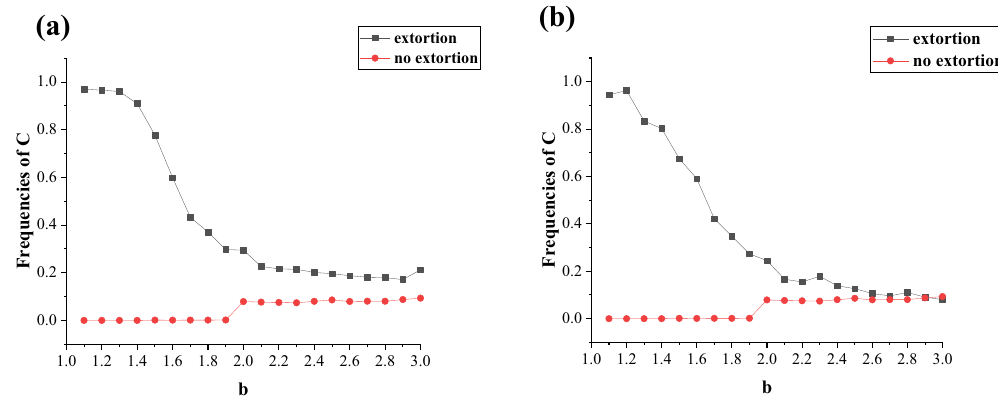
Figure 5. Comparison of cooperation evolution with and without extortion strategies for the different χ : ( a ) cooperation frequencies for χ = 1.5 , ( b ) cooperation frequencies for χ = 4 . In the simulations, the game parameters are m 1 = 3, and c = 1